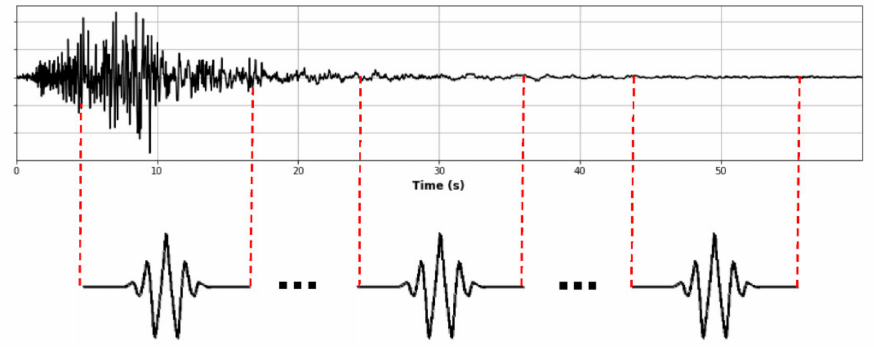
Figure 6. Translation of wavelets over time.